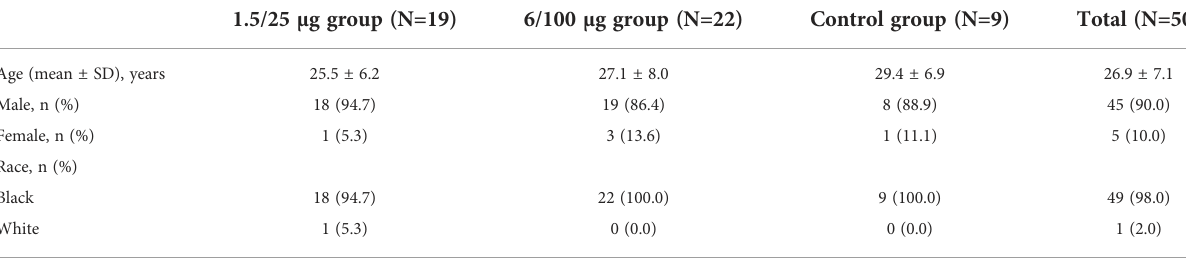
TABLE 1 Demographic characteristics of the study participants included in the SBA